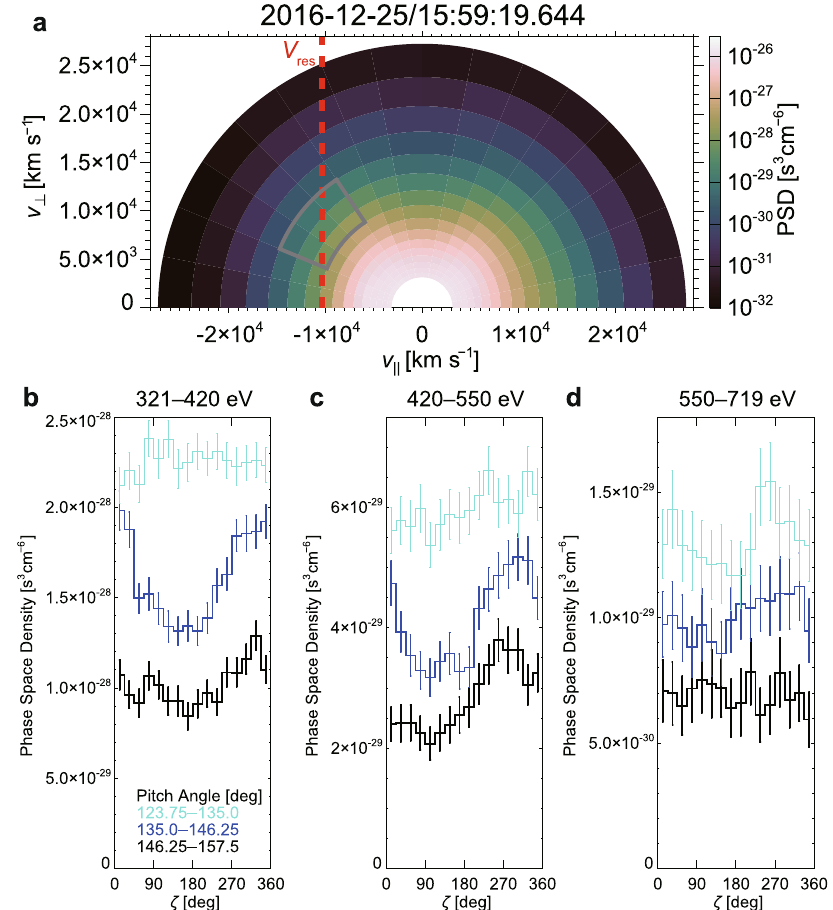
Fig. 3 | Electron velocity distribution function (Event 1). a Gyro-averaged elec- tron velocity distribution function (28.3 – 2112eV) with the cyclotron resonance velocity ( V res ) shown as a red dashed line. b – d histograms of electron phase space density(PSD)in ζ directionat3energybins(fan-shaped areasurroundedbyagray curve in Fig. 3a). The nongyrotropy signi fi cantly exceeded 2 σ error bars (see Methods,subsectionElectronand ionmeasurementsbyFPI)around V res ,whilethe electrons did not exhibit clear nongyrotropy around the pitch angle of about 130°